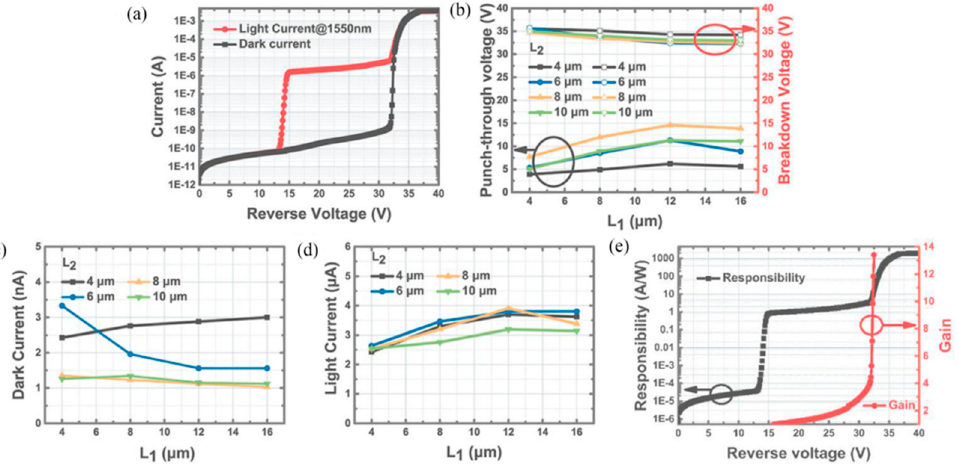
Figure 43. ( a ) I–V characteristics, ( b ) punch-through voltage (V pt ) and breakdown voltage (V br ), ( c ) dark current curves, ( d ) light current curves, ( e ) responsivity/multiplication gain vs. reverse voltage. Reproduced from [95], IEEE, open access, 2022.